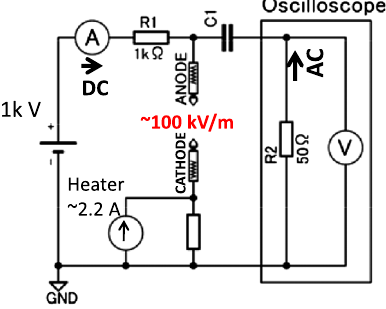
FIG. 3. Equivalent circuit of measurement setup.